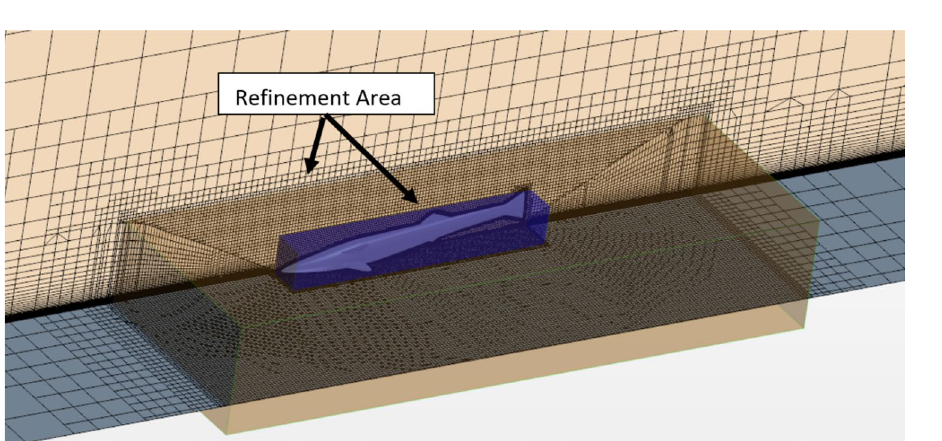
Figure 11. The mesh around the remora fish when attached onto the flat plate (Created using Simcenter STAR- CCM + 2019.2.1 Build